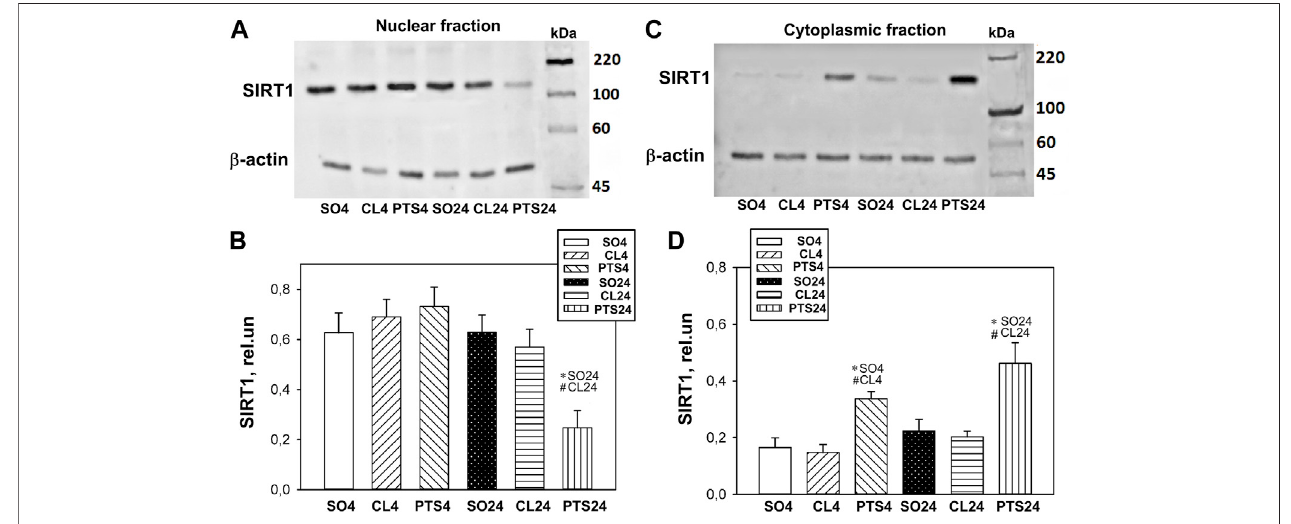
FIGURE 1 | SIRT1 expression in nuclear (A,B) and cytoplasmic (C,D) fractions of penumbra tissue 4 or 24 h after photothrombotic stroke in the cerebral cortex of rats. One-way ANOVA. M ± SEM. n = 7. * p < 0.05 compared to sham-operated animals, # p < 0.05 compared to the contralateral cerebral cortex of the same animals.